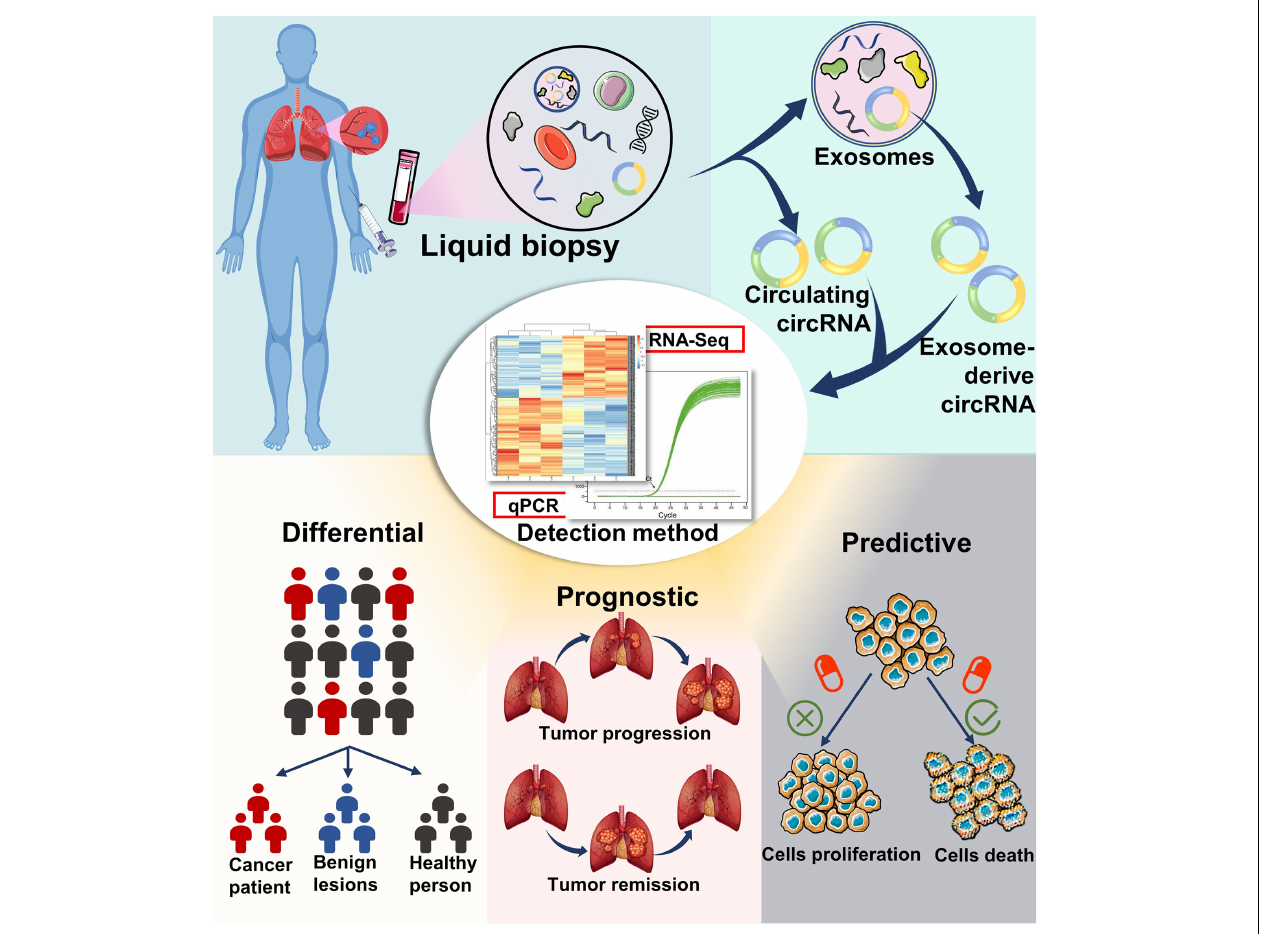
FIGURE 3 | Potential application of circular RNAs as liquid biopsy biomarkers. circRNA biomarkers can be isolated from blood, as well as from the exosomes in blood. Detection and analysis of circRNAs can be completed using RNA-seq, qPCR, and other methods. circRNAs may serve as potential biomarkers for diagnosis, prognosis, and therapy selection of